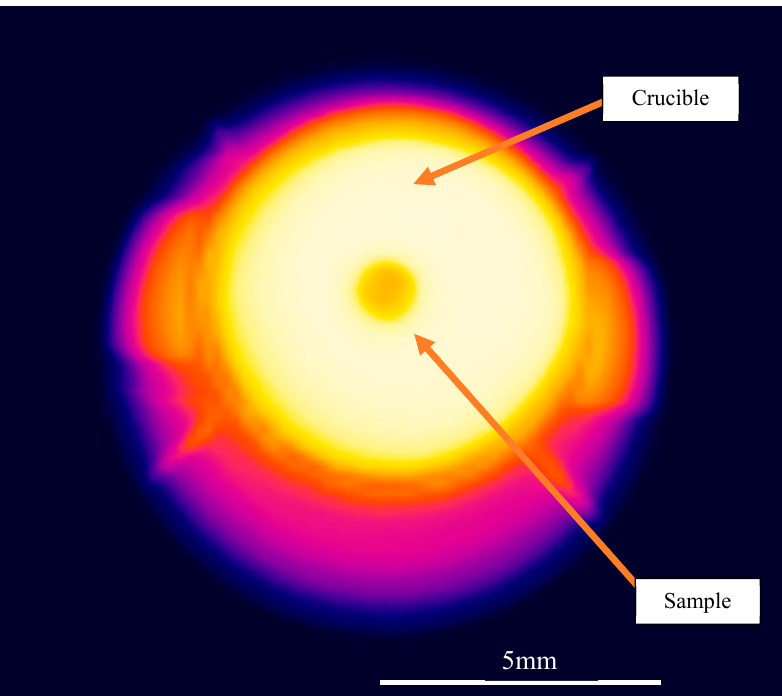
Figure 1. Typical thermography image taken from the confocal scanning laser microscope.